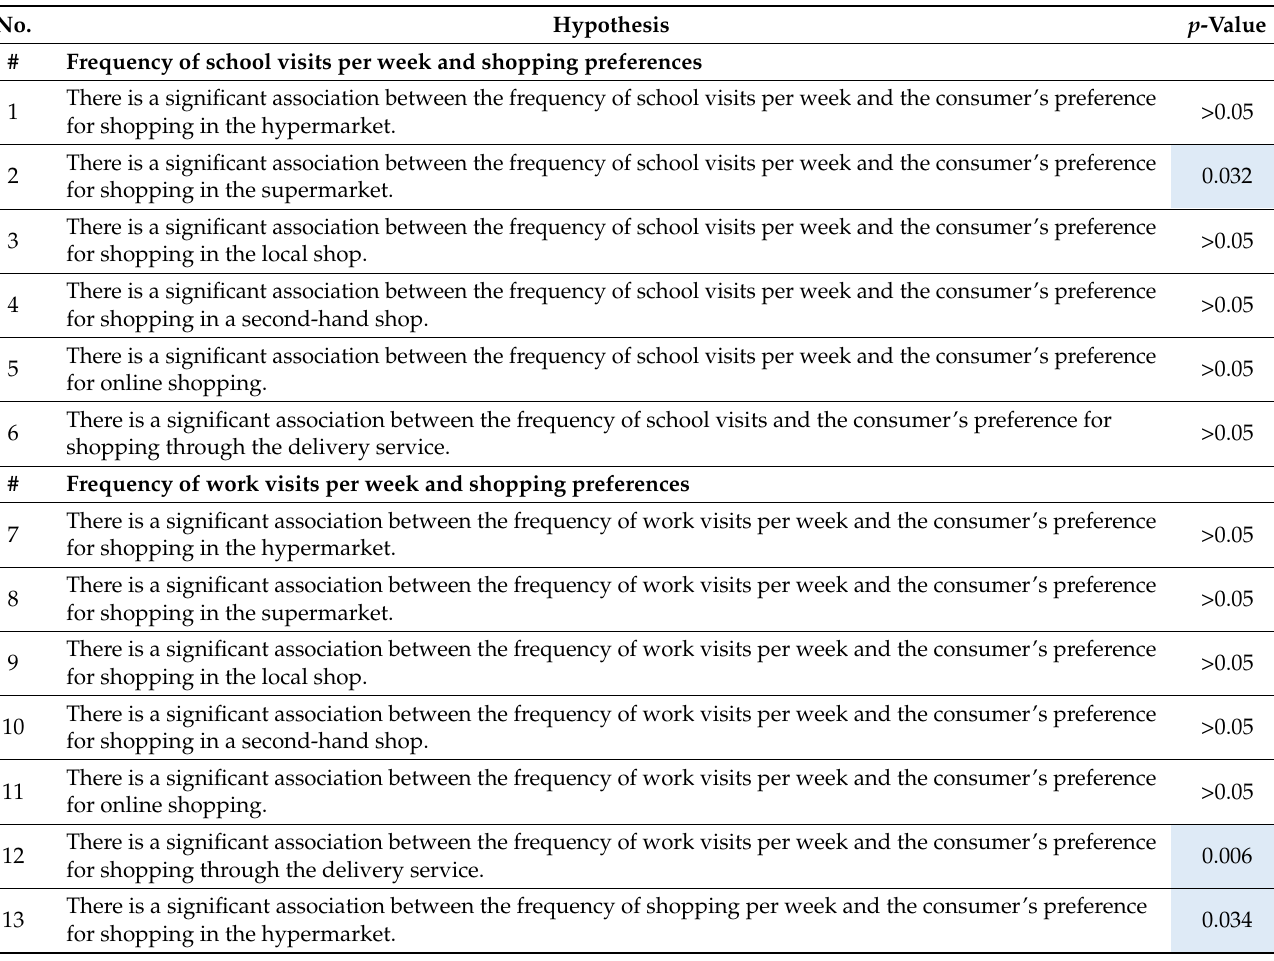
Table 2. Hypothesis summary with statistical significance divided into six